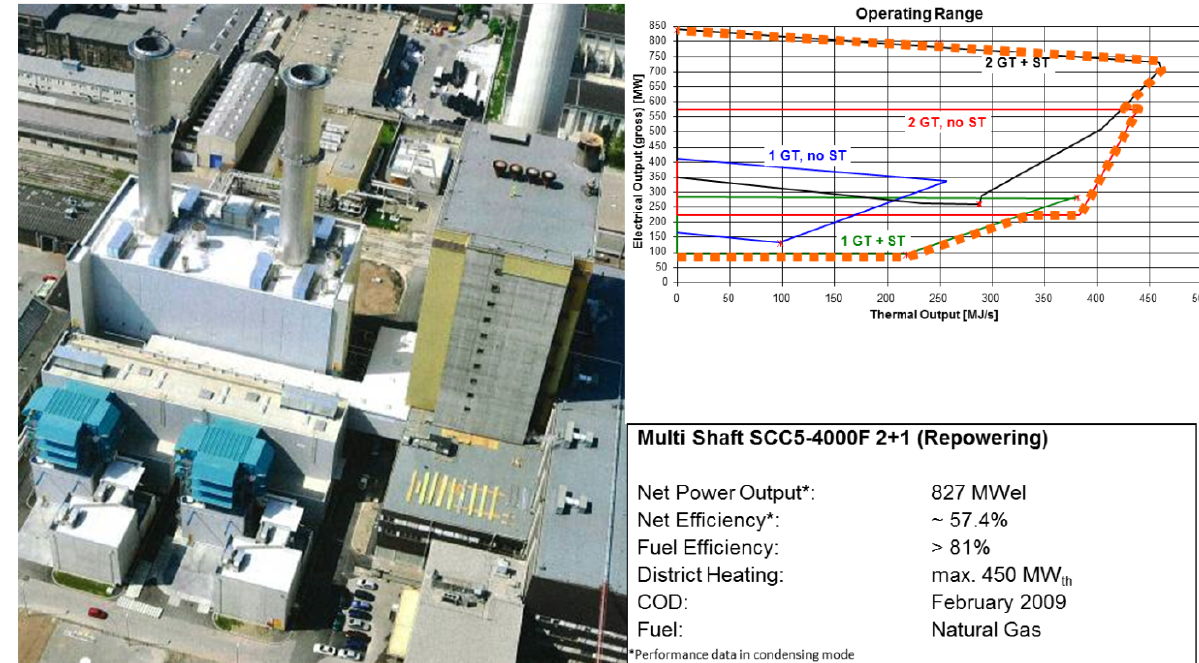
Figure 2. Simmering Power Station (repowered), Vienna,